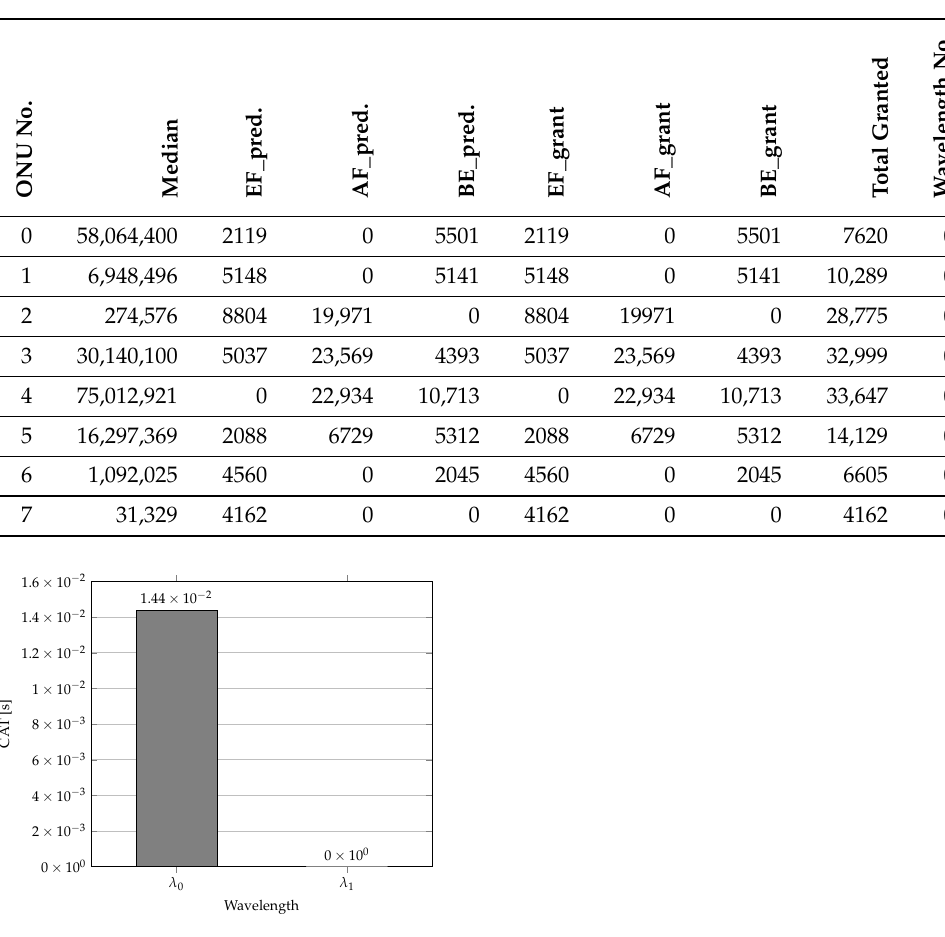
Table 3. Example of the wavelength allocation for actual data transmission demands in bytes from 8 ONUs in cycle No. 27 using Method 2.